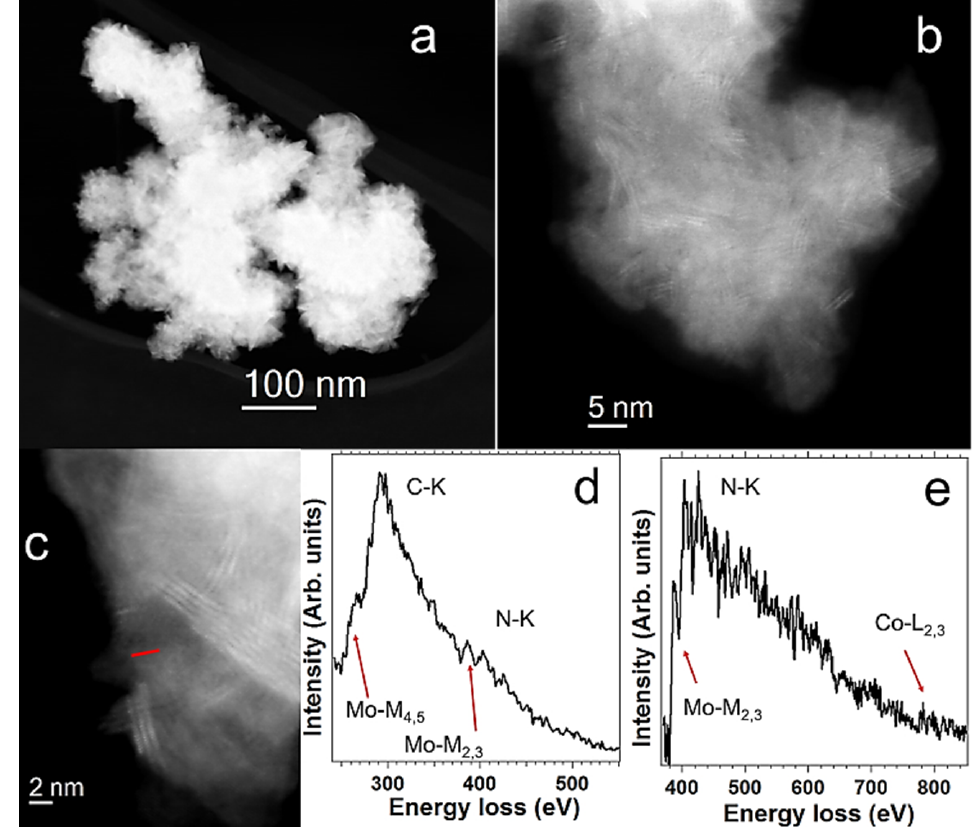
Figure 2 . Scanning transmission electron microscopy (STEM) analyses. ( a – c ) High-angle annular dark field (HAADF) STEM images of a MoSe 2 -CoP flake, where the 1T phase can be identified ( b , c ). ( d , e ) An EELS spectrum-line is recorded in the highlighted area of ( c ). 15 EEL spectra, recorded in the red-marked line of the ( c ), were selected and added. Two different energy regions are displayed, where different elements and absorption edges can be observed, see ( d , e ). These elements correspond to MoSe 2 (Mo-M edge) and to the CoP moieties (C-K, N-K and Co-L edges). In order to follow the modification that occurred on MoSe 2 and WSe 2 , with the ultimate goal to verify the successful formation of MoSe 2 -CoP and WSe 2 -CoP, diverse spectroscopic, thermal, and microscopy imaging techniques were employed. For starters, typical bands of pyridine rings are seen in the IR spectrum of f-MoSe 2 due to the successful coordination of the former at the metal of MoSe 2 , at 3430 (N-H), 1651 (C-N) and 1411 cm − 1 (C-H (Figure 3a). On the other hand, CoP shows the carbonyl vibration mode at 1690 cm − 1 , due to the surface -COOH units. The IR spectrum of MoSe 2 -CoP is occupied by the characteristic band at 1641 cm − 1 owned to the carbonyl amide stretching due to the successful hybridization, while N-H vibrational features are evident in MoSe 2 -CoP. In a similar manner, the effective grafting of amino groups onto WSe 2 is obvious by the characteristic bands due to the pyridine ring at 3430 (N-H), 1646 and 1329 (C-N), and 1403 cm − 1 (C-H) (Figure S3a). Additionally, the coupling of amino-modified WSe 2 with the carbonyl terminated CoP is shown at 1650 cm − 1 , due to the carbonyl amide stretching, as seen in Figure